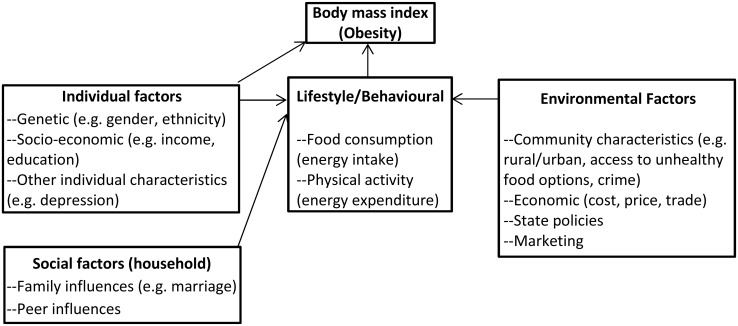
Adapted theoretical framework for available multilevel factors driving adult obesity in South Africa.